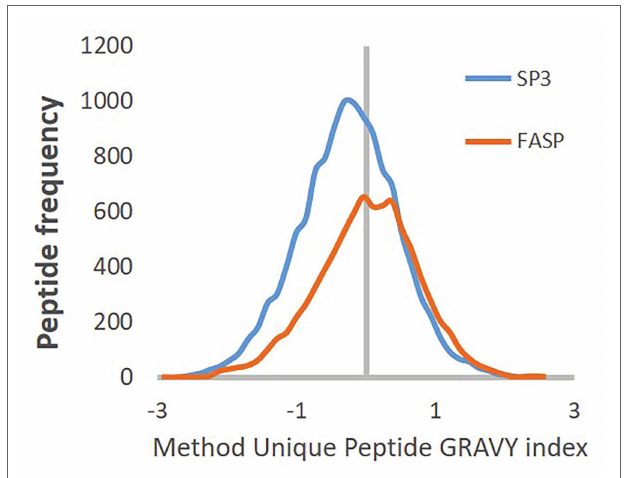
FIGURE 7 | GRAVY index distribution of peptide uniquely identified by FASP (orange) or SP3 Carboxy (blue)